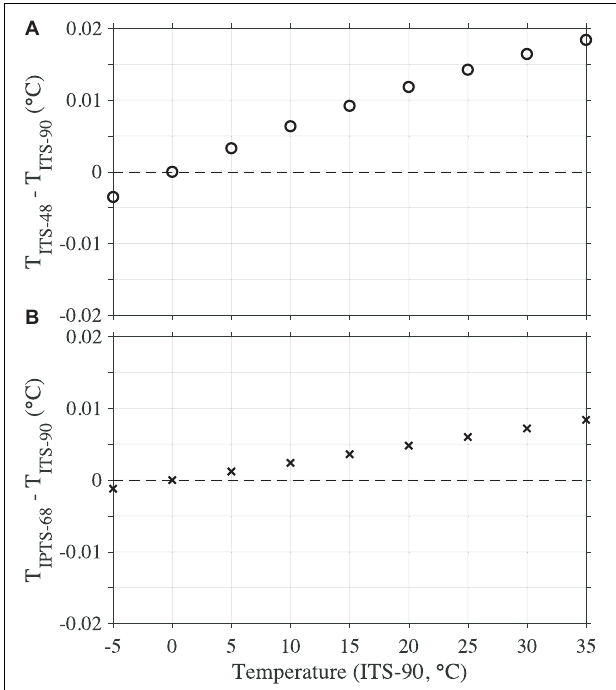
FIGURE 2 | Comparison of water temperature at different temperature scales: ITS-48, IPTS-68, and ITS-90. (A) The differences between ITS-48 and ITS-90 against ITS-90. (B) The differences between IPTS-68 and ITS-90 against ITS-90. Water temperatures on ITS-48 or IPTS-68 can be converted to ITS-90 using the TEOS-10 functions of “gsw_t90_from_t48” and “gsw_t90_from_t68,” respectively (IOC et al.,